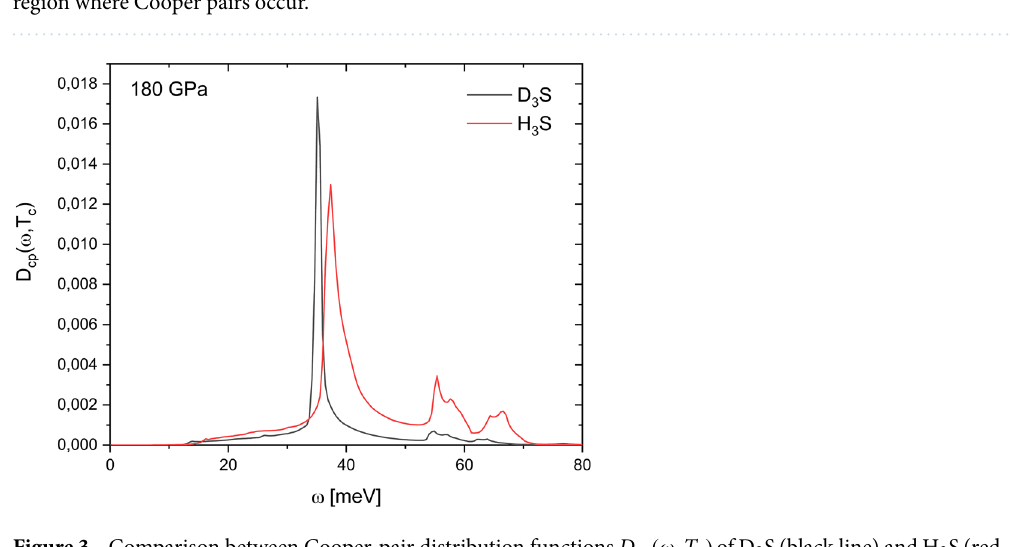
Figure 3. Comparison between Cooper-pair distribution functions D cp (ω , T c ) of D 3 S (black line) and H 3 S (red line) calculated at 180 GPa.